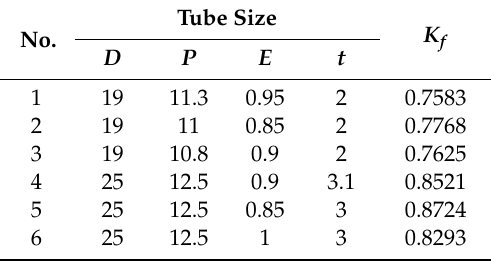
Table2. Experimentalmeasurementsofthesti ff nessequivalentfactoroftheCDtubeswithdi ff erentsizes.